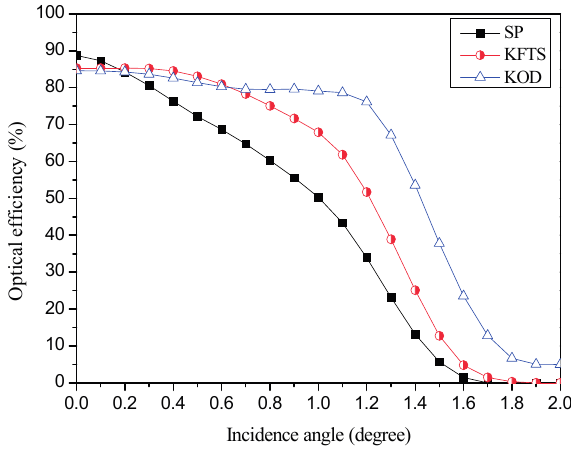
Figure 11. Optical efficiency of the Fresnel lens with three types of